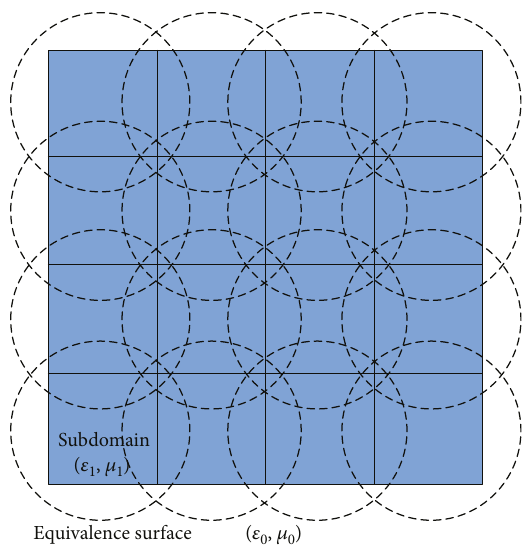
Figure 3: The dielectric object decomposed into subdomains and each subdomain enclosed by an equivalence